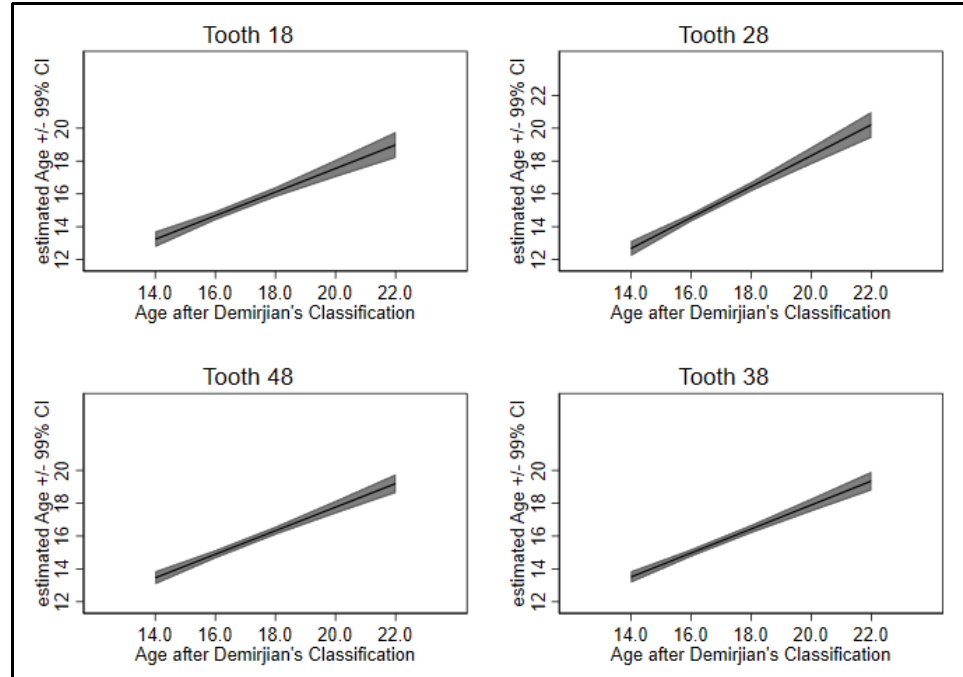
Figure 2. Estimated values for age and tooth mineralization with confidence intervals.